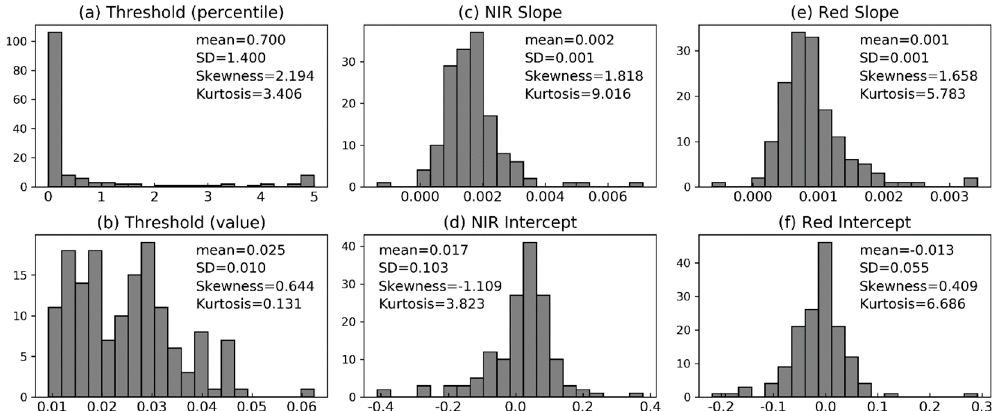
Figure 8. Identification of PIV pixels for 150 sites. Plots (a) and (b) show percentiles and values of identified near-infrared thresholds. Plots (c) and (d) show slopes and intercepts of linear regression models for the near-infrared band. Plots (e) and (f) show slopes and intercepts of linear regression models for the red band.